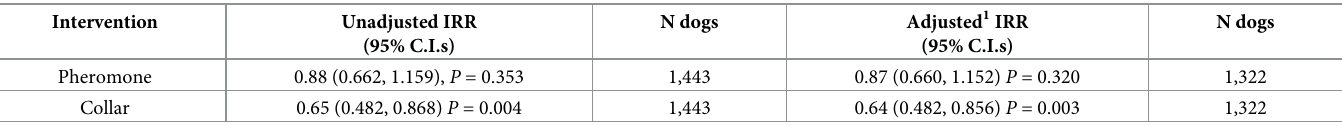
Table 3. Seroconversion incident rate ratio (IRR) amongst dogs under each intervention: unadjusted and adjusted estimates calculated relative to the control arm, by fitting to mixed-effect complimentary log-log models. Intervention